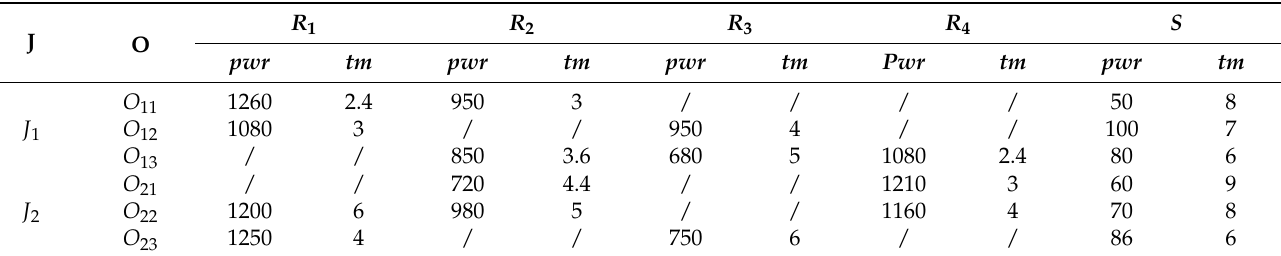
Table 1. Operations and storages of two jobs in the